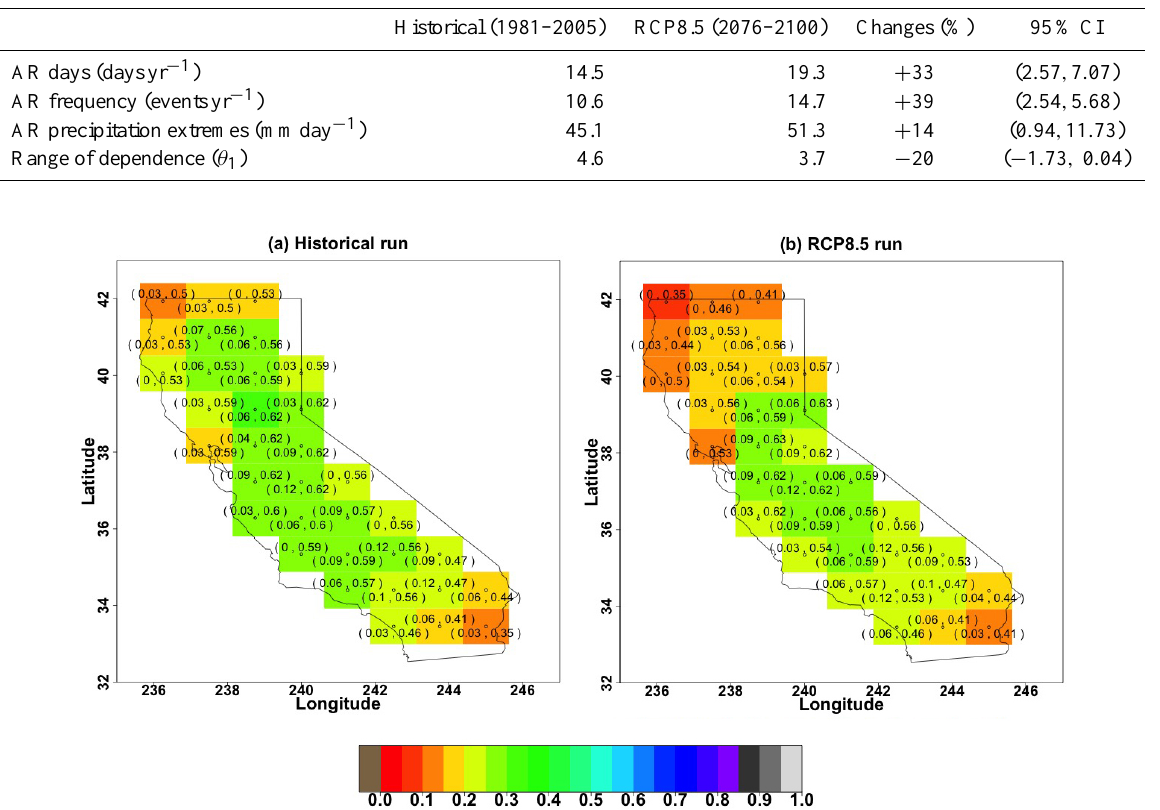
Figure 8. A summary of the changes in pairwise spatial dependence from (a) 1981–2005 to (b) 2076–2100 for multi-model ensemble simulations. Discrete colors at each location represent the number of locations with strong dependence (i.e., extremal coefficient < 1 . 3). The values in parenthesis at each color box represent lower and upper bounds of the 95% confidence interval for the number of locations.